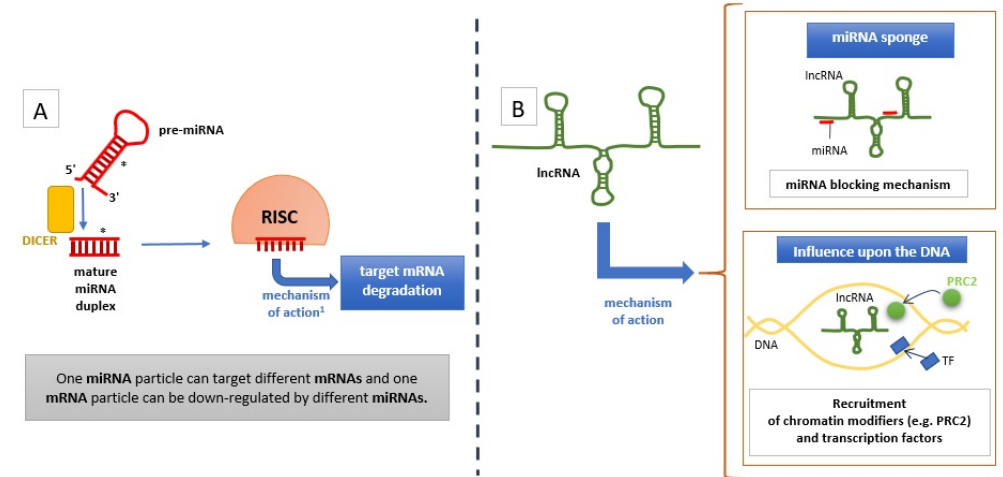
Figure 1. Mechanism of action of miRNA ( A ) and lncRNA ( B ). * = miRNA fragment more close to 3 ′ end, 1 = mRNA degradation is a crucial mechanism of action of miRNA, other mechanisms, like translational repression or even trans- lational activation, are also possible; abbreviations: RISC = RNA-induced silencing complex, TF = transcription factors, PRC2 = polycomb repressive complex 2, a complex with histone methyltransferase activity.